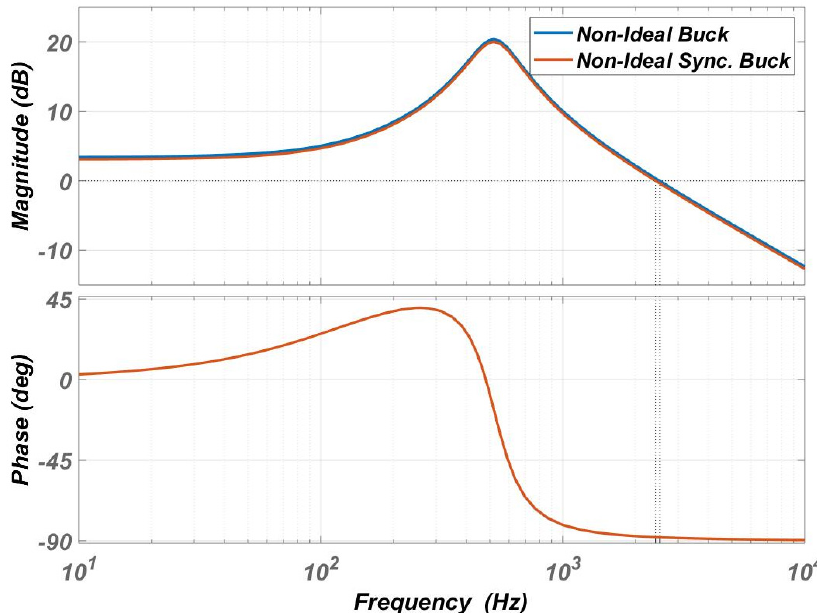
Figure 12. Bode plot for non-ideal buck and synchronous buck converters.